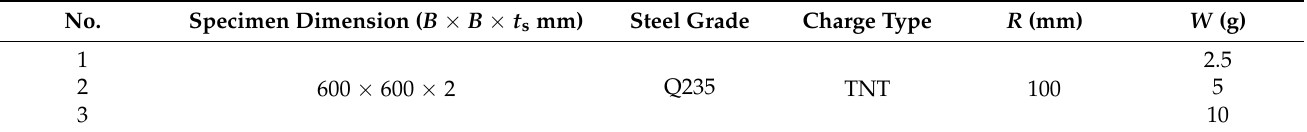
Figure 1. Schematic view of fixed steel sheet (unit: mm). Table 1. Summary of test